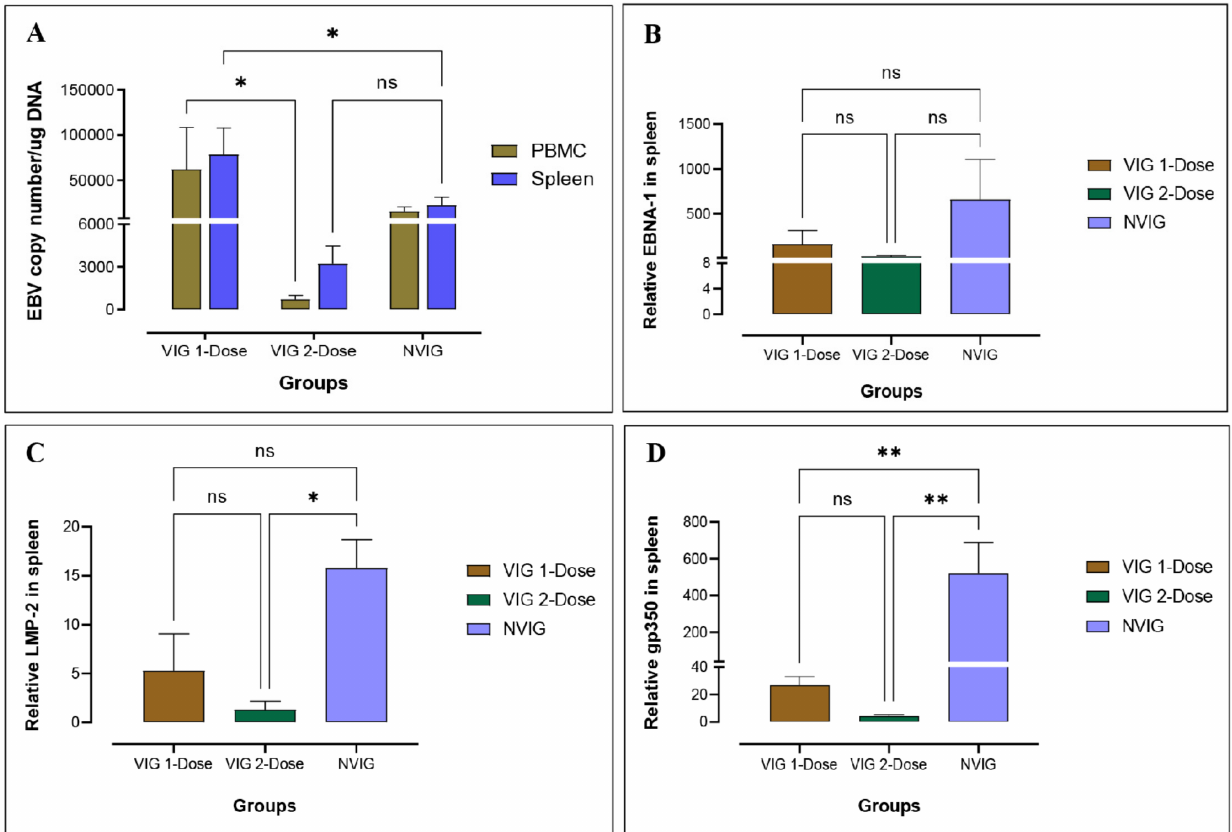
Figure 2. Determination of viral load and EBV gene expression in rabbits. Comparison of viral load by qPCR in the spleen and PBMCs of VIG 1-dose and VIG 2-dose compared to NVIG ( A ). EBV gene expression in VIG 1-dose and VIG 2-dose compared to NVIG for EBNA1 ( B ), LMP-2 ( C ), and gp350 ( D ) in the rabbit spleen. All the data here are normalized with NVNIG. ns: p > 0.05, * p ≤ 0.05, ** p ≤